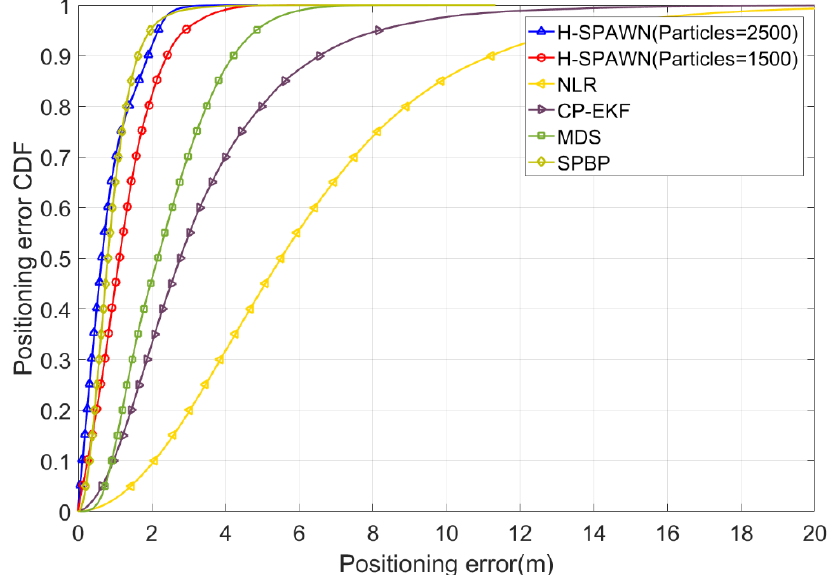
Figure 6. Positioning error CDF comparisons for all vehicles: H-SPAWN (particle number = 2500), H-SPAWN (particle number = 1500), NLR, CP-EKF, MDS, SPBP (positioning errors from 200 simulation trials).